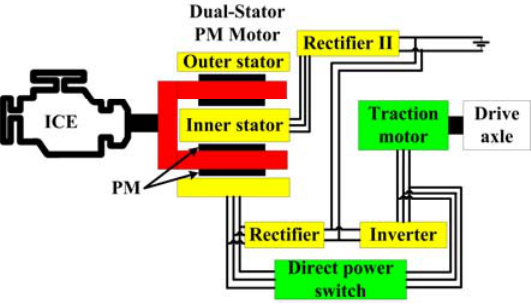
Figure 22. Dual-stator PM brushless ECVT.